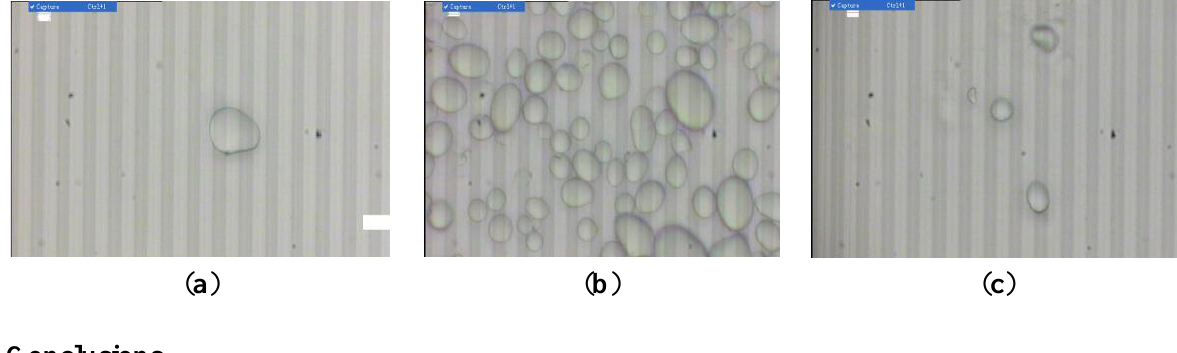
Figure 17. The separation results of starch particles. ( a ) Non-separated starch particles; ( b ) the first separation sample; ( c ) the second separation